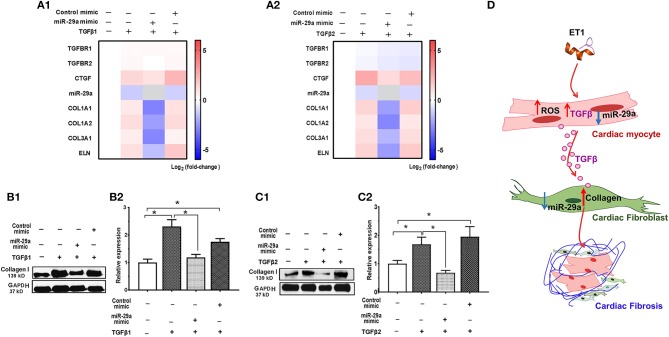
TGFβ-stimulated collagen expression in neonatal rat cardiac fibroblast cultures is prevented by miR-29a mimic. (A1,A2) Heat maps summarizing effect of TGFβ1 and TGFβ2 on expression of miR-29a and select pro-fibrotic target genes in cardiac fibroblasts. TGFβ1 and TGFβ2 suppress miR-29a expression and increase expression of pro-fibrotic genes, which is antagonized by the miR-29a-mimic, in cardiac fibroblasts. Differentially-expressed genes are shown in graduated red (up-regulated) or blue (down-regulated) according to their log2 fold change compared to control (untreated cells); miR-29a in the miR-29a-mimic condition is depicted in gray. (B1,C1) Representative western blot images for collagen type I following TGFβ1 and TGFβ2 treatment of cardiac fibroblasts (from one experiment) demonstrates that TGFβ1 and TGFβ12 stimulate collagen expression in cardiac fibroblasts, which is antagonized by a miR-29a-mimic. (B2,C2) Summary of western blot data for collagen type I following TGFβ1 or TGFβ2 treatment of cardiac fibroblasts from three experiments illustrates that TGFβ1 and TGFβ2 increase collagen type I expression in cardiac fibroblasts, which is inhibited by a miR-29a-mimic (data are expressed as mean ± S.D; n = 3. One-way ANOVA and Tukey's test were used to compare treatment conditions; *P < 0.05). (D) Schematic for stimulation of cardiac fibrosis following activation of ET1 signaling. ET1 promotes TGFβ secretion by cardiac myocytes, which downregulates miR-29a and de-represses its pro-fibrotic target genes in cardiac fibroblasts, leading to collagen deposition.